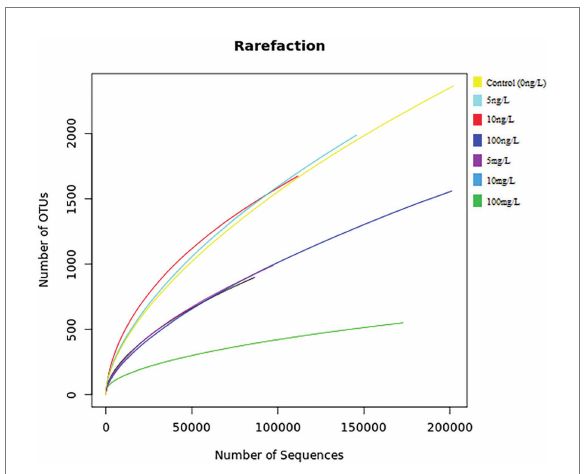
FIGURE 2 Rarefaction curves for the seven samples [control 0 ng/L EE2 (yellow), 5 ng/L EE2 (light blue), 10 ng/L EE2 (red), 100 ng/L EE2 (dark blue), 5 mg/L (purple), 10 mg/L (blue), and 100 mg/L (green)] showing the coverage depth as compared to the total number of sequences. The x-axis represents the number of sequences sampled while the y-axis represents the number of OTUs. The legend on the top right indicates each color coded to its respective